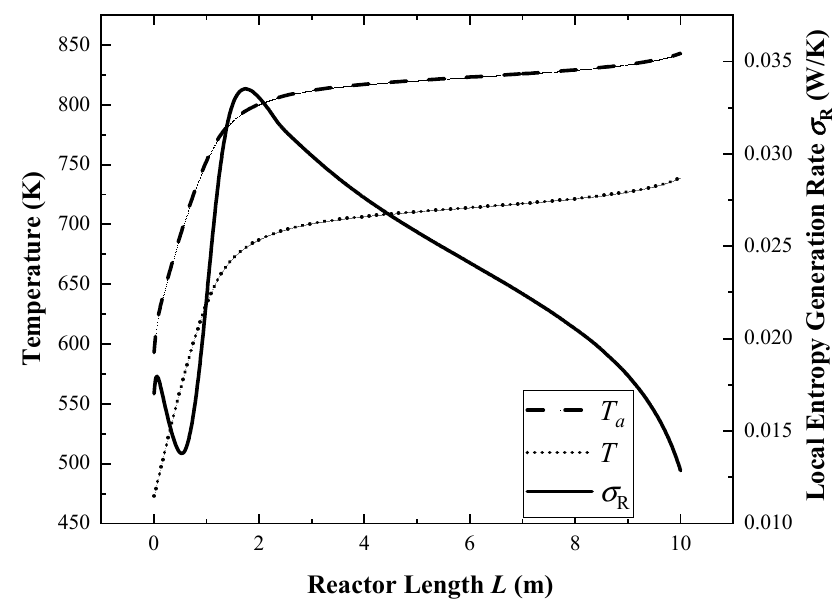
Figure 4. The distributions of T a , T, and σ R along the reactor.